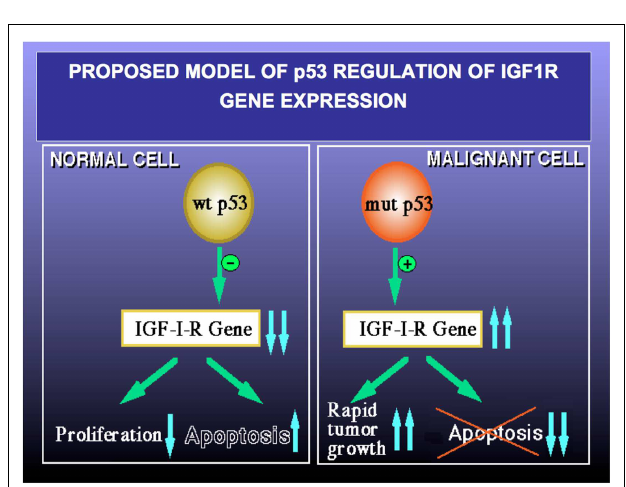
FIGURE 2 | Immunohistochemical staining of p53 (A–D) and BRCA1 (E–H) in primary and metastatic USC . p53: (A) Metastasis , a focus of increased atypia in metastatic tumor. Enlarged, pleomorphic and bizarre nuclei, atypical mitoses. H&E, × 400. (B) Primary tumor , strong nuclear staining in nearly all neoplastic cells (grade IV). No staining in adjacent non-neoplastic glands. (C) Metastasis , strong nuclear staining in nearly all neoplastic cells (grade IV). (D) Metastasis , a focus of increased atypia.Very